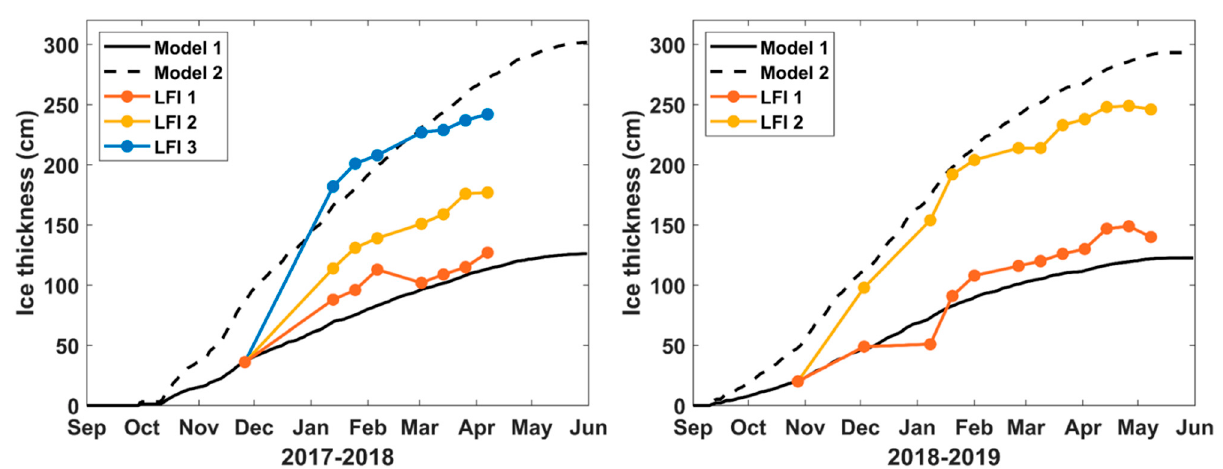
Figure 8. Comparison between ice thickness model estimates and vertical offsets observed from SAR SPO (left: 2017–2018, right: 2018–2019). The black solid and dashed lines are the estimates by Model 1 and Model 2, respectively. The orange, yellow, and blue markers represent the relative ice thickness reversed from the vertical offsets of LFI1, LFI2, and LFI3 in Figure 5, respectively. The SPO starting points are referenced to the Model 1 estimates of the first SAR acquisition dates.